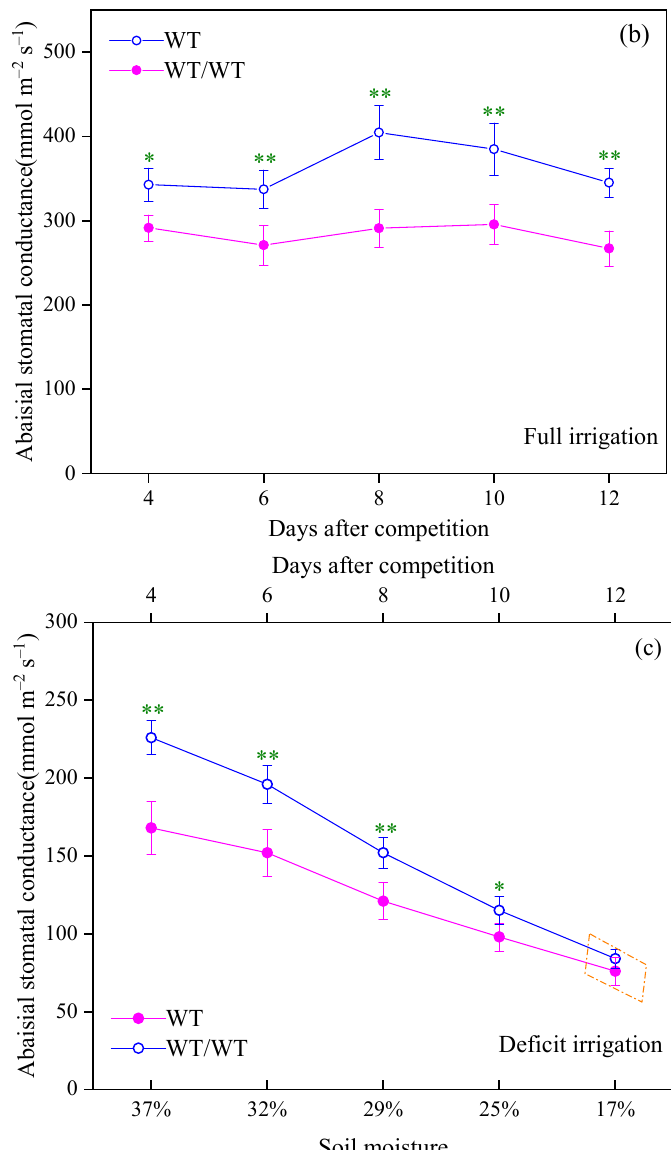
Figure 2. Variation of leaf water potential (( a ) deficit irrigation), abaxial stomatal conductance (( b ) full irrigation, ( c ) deficit irrigation) in the single plant and competing plants of wild type tomato (* p < 0.05, ** p < 0.01).